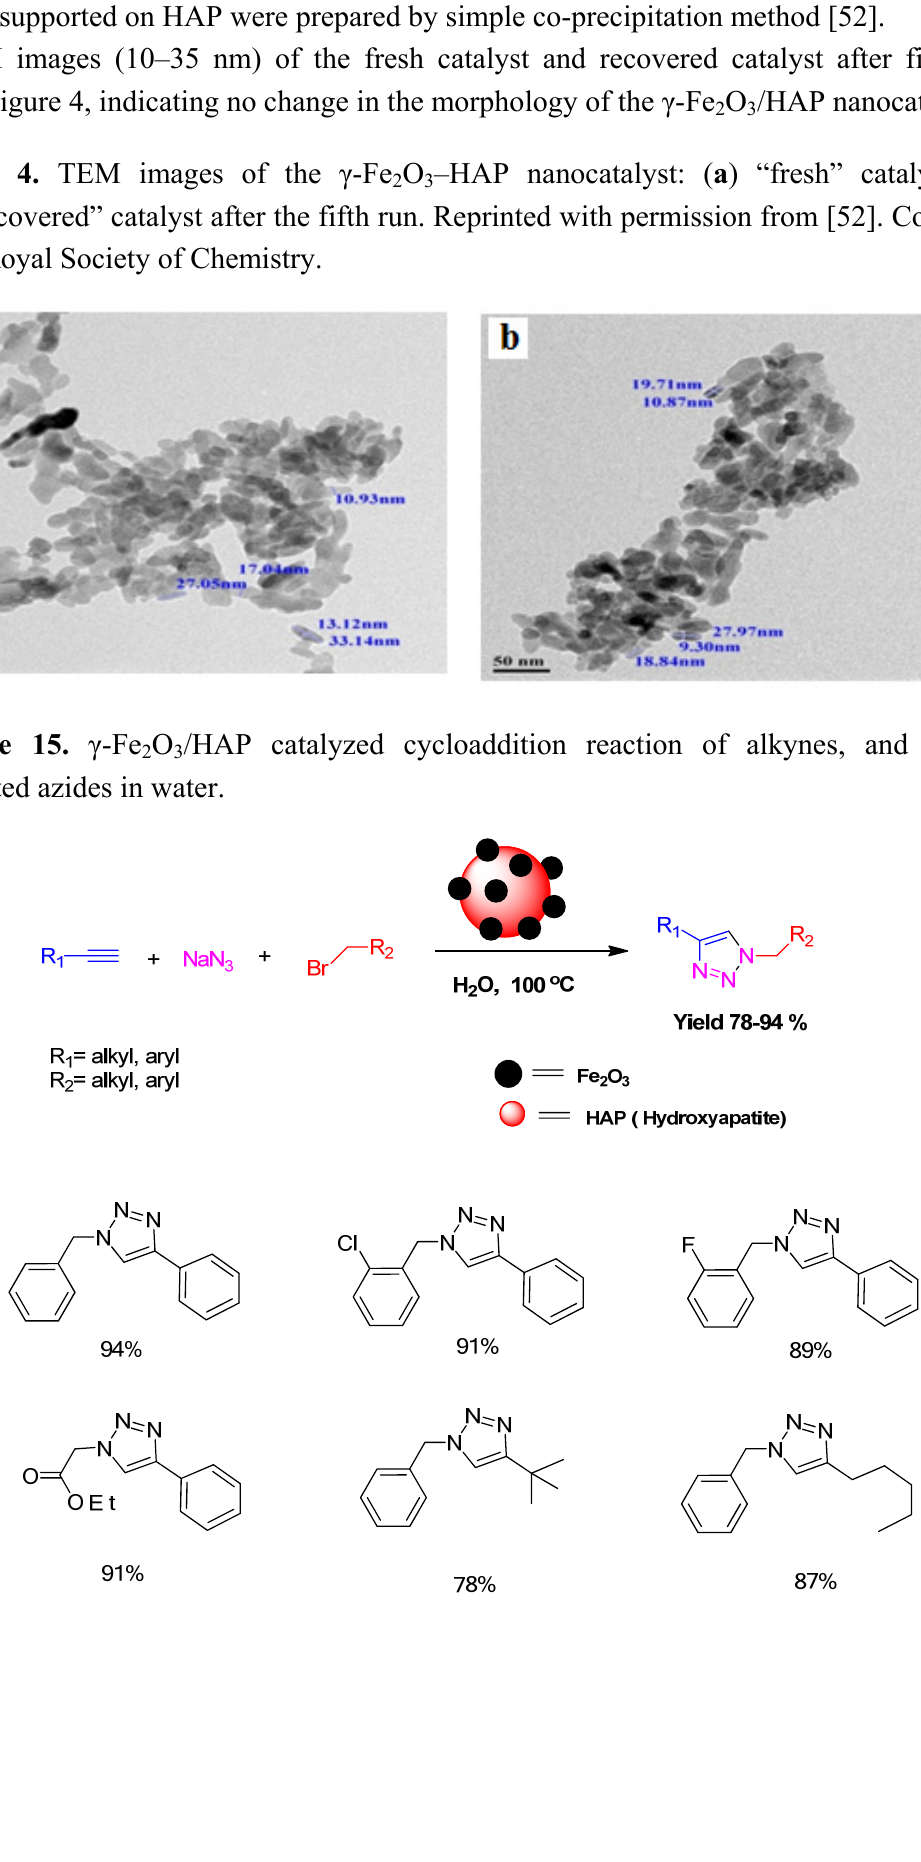
O –HAP nanocatalyst: ( a ) “fresh” catalyst and 2 3